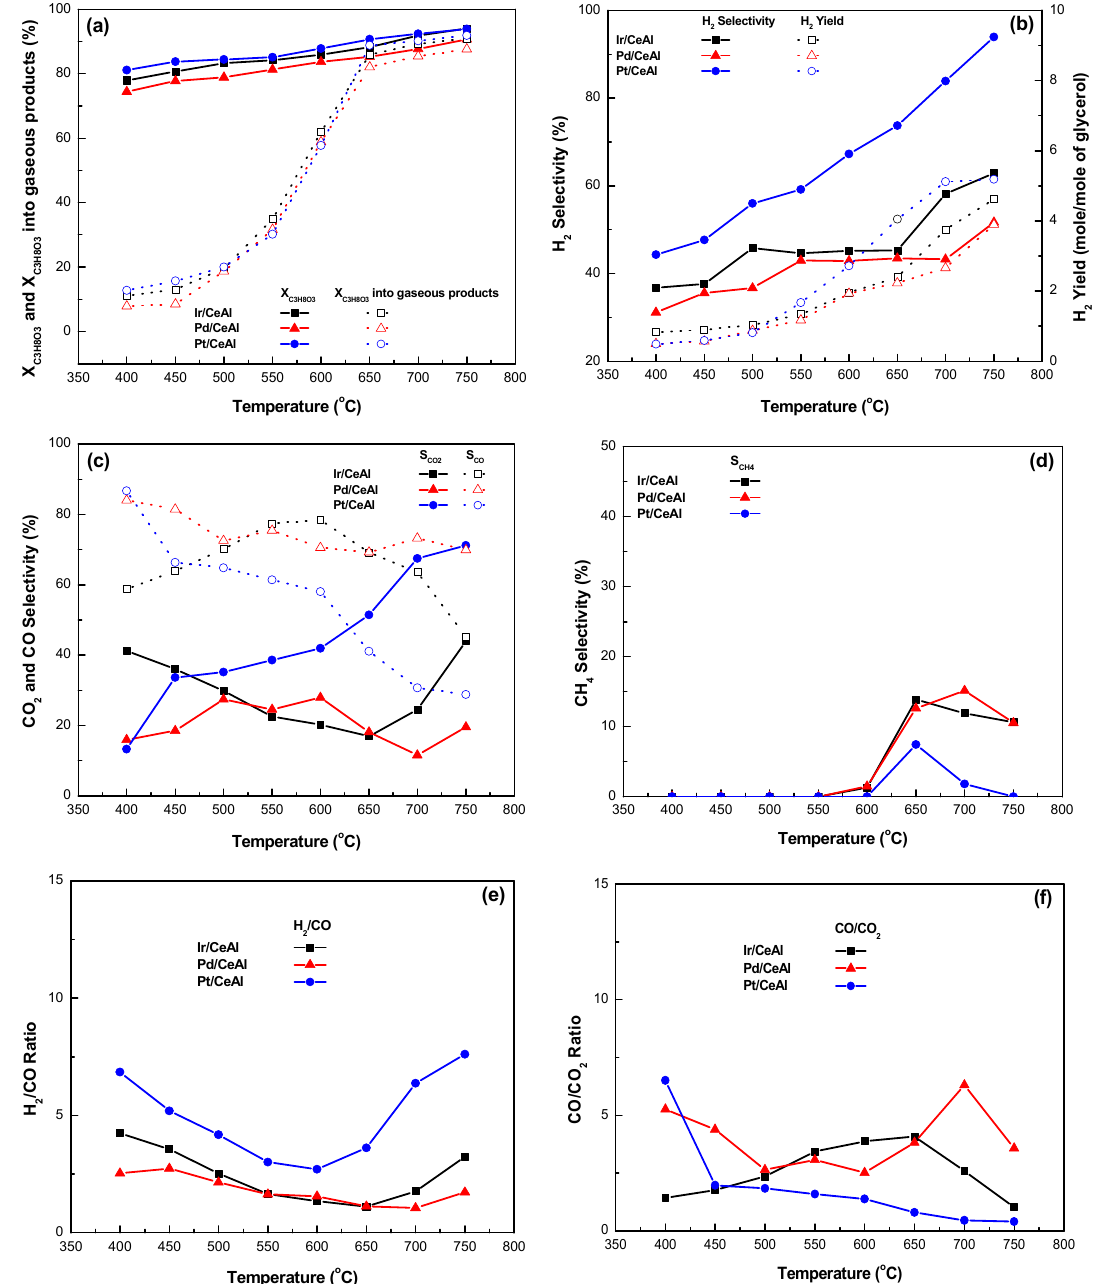
Figure 7. ( a ) Total C 3 H 8 O 3 conversion and C 3 H 8 O 3 conversion into gaseous products, ( b ) H 2 selectivity and yield, ( c ) CO 2 and CO selectivity, ( d ) CH 4 selectivity (y-axis on a different scale), ( e ) H 2 /CO molar ratio, and ( f ) CO/CO 2 molar ratio (activity experiments).